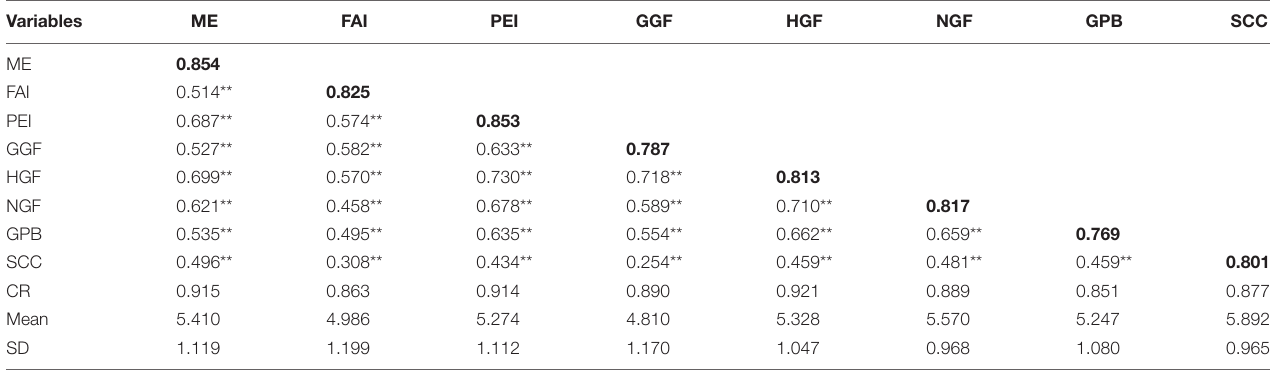
TABLE 1 | Descriptive statistics, discriminate validity, and correlations among